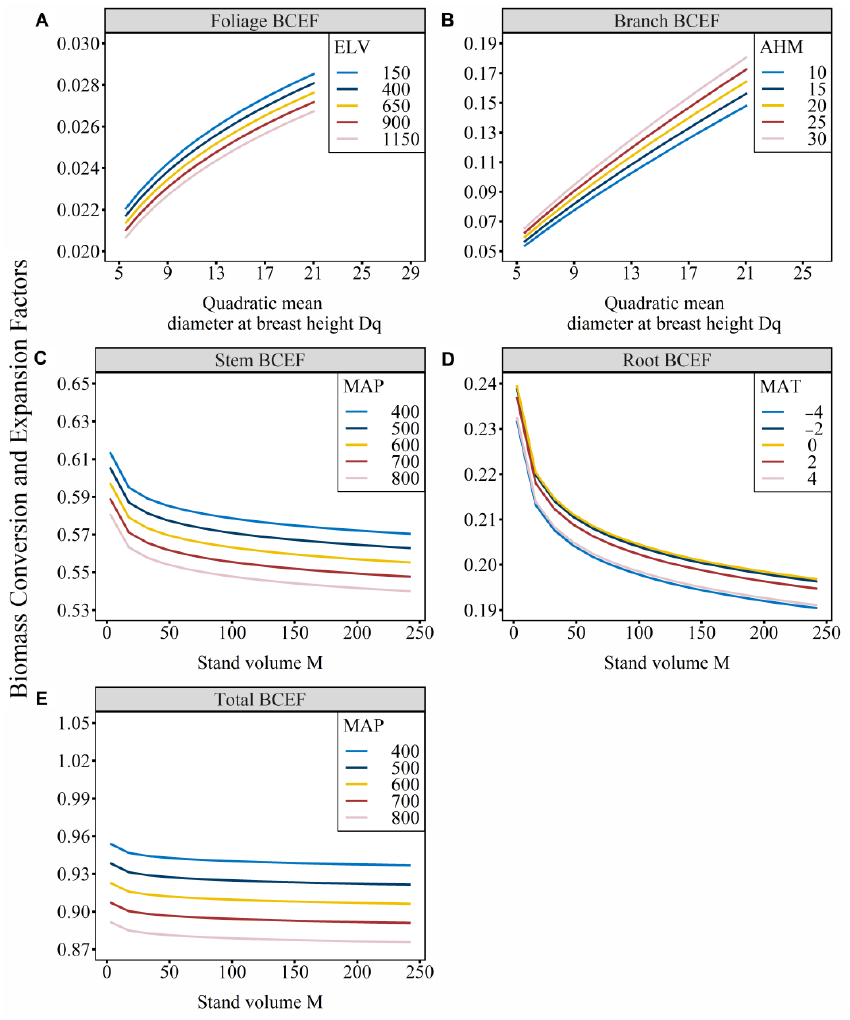
Figure 3. The variation in the BCEF s of five components (( A ): branch, ( B ): foliage, ( C ): stem, ( D ): root and ( E ):total) along abiotic variable gradients.